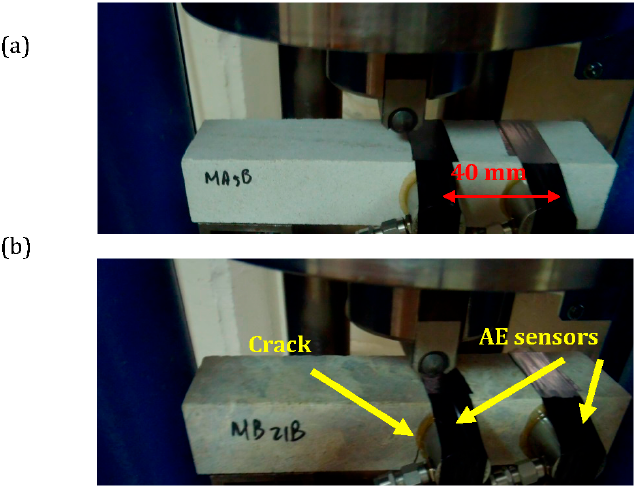
Figure 2. ( a ) Three point bending of ( a ) MA and ( b ) MB marble with concurrent AE monitoring by two sensors.